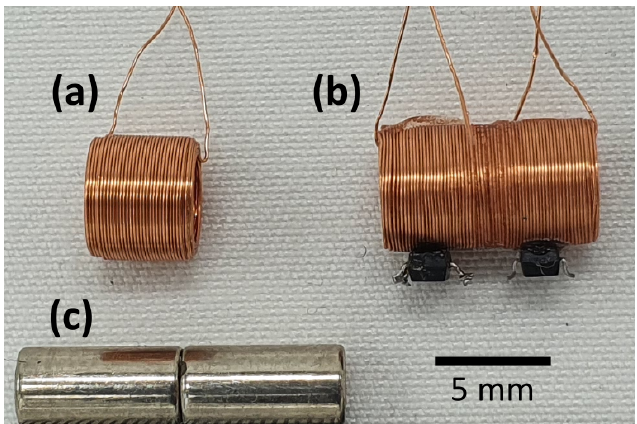
Figure 1. An example of a single coil ( a ), a coil assembly with two hall effect sensors mounted ( b ), and the magnet assembly with two magnets joined with opposing magnetic poles ( c